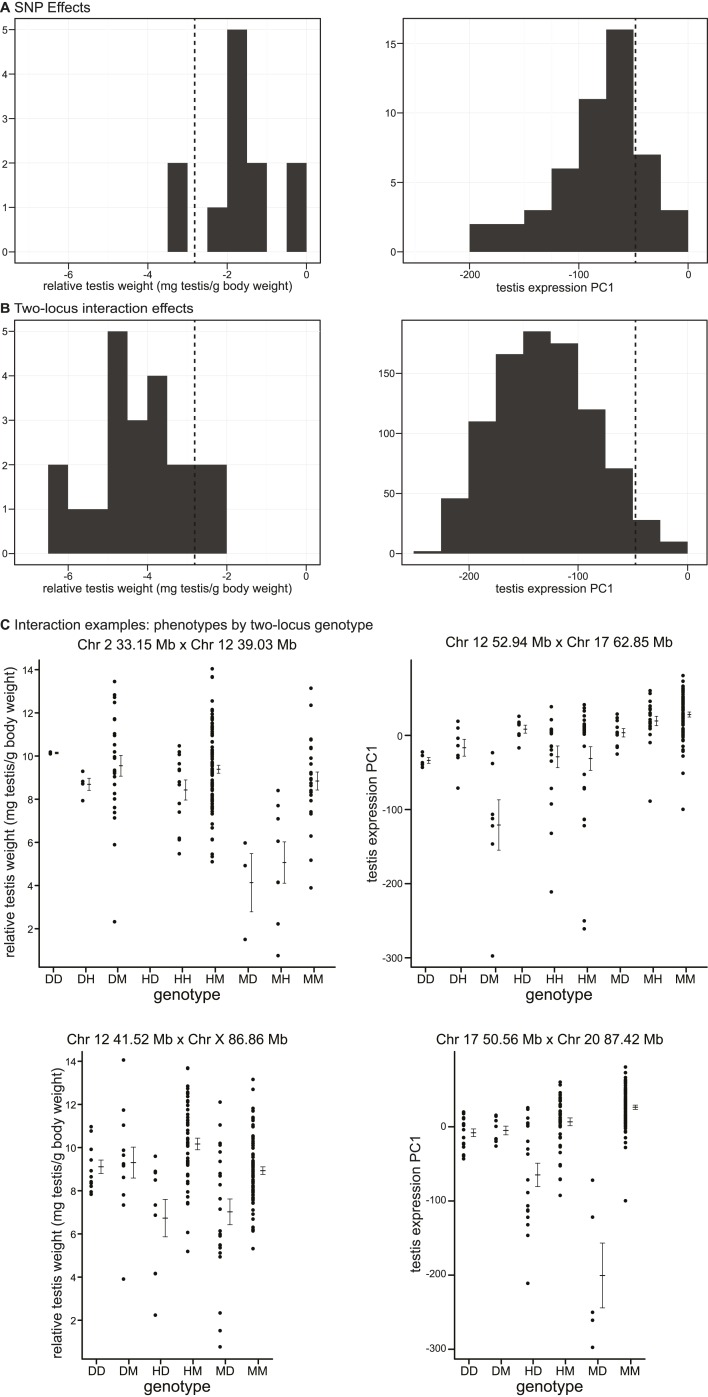
Phenotypic effects of testis-weight loci and interactions.Histograms showing maximum deviations from the population mean for (A) single SNPs and (B) two-locus interactions. Dashed vertical lines indicate minimum values observed in pure subspecies males. (C) Examples of phenotypic means by two-locus genotype for autosomal–autosomal and X–autosomal interactions. Genotypes are indicated by one letter for each locus: D—homozygous for the domesticus allele, H—heterozygous, M—homozygous musculus.